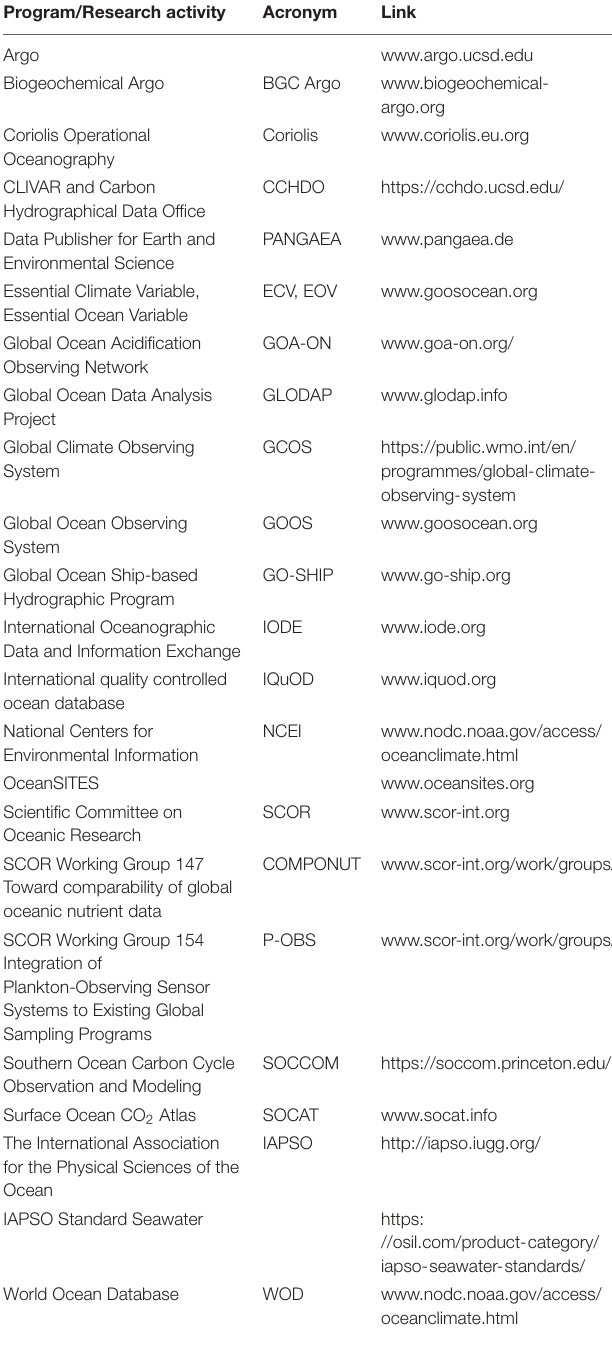
TABLE 1 | Significant ocean science programs and research